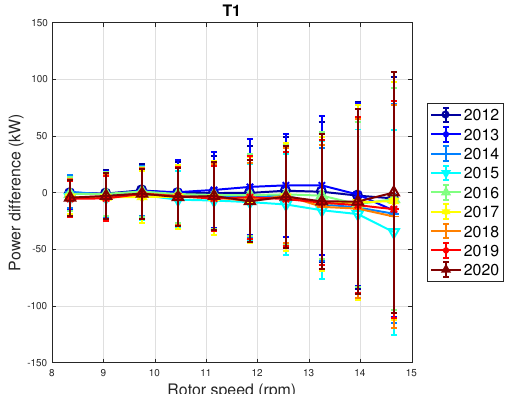
Figure 5. A sample binned rotor speed–power curve in Region 2 for WF1: the curves are reported in the form of difference with respect to the year